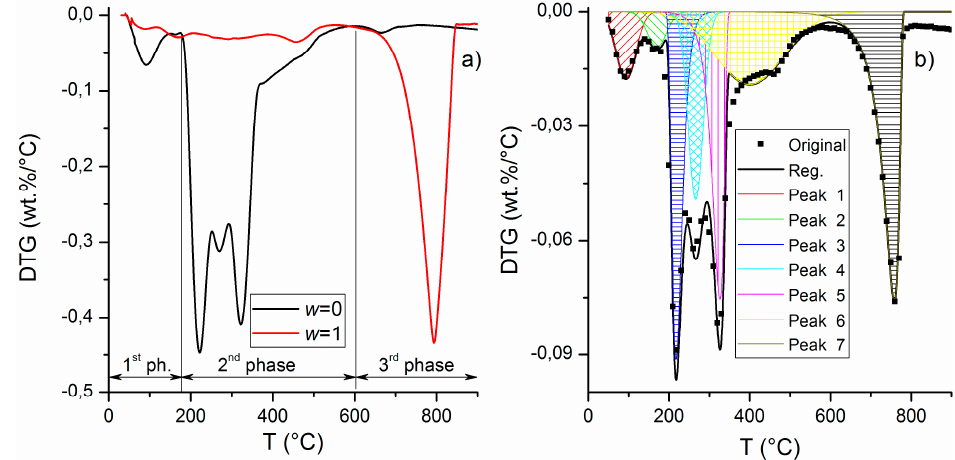
Figure 1. Derivative thermogravimetric (DTG) curves for pyrolysis of samples with mass fraction equal to 0 and 1 ( a ) and deconvolution of DTG curve for mass fraction of defecation lime in sample equal to 0.4 ( b ) at heating rate of 10 °C/min. Table 2. Deconvolution parameters of the DTG curve for mass fraction of defecation lime in the sample equal to 0.4.